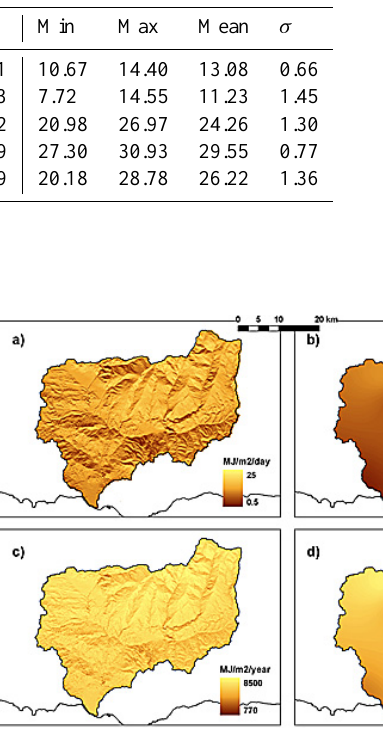
Fig. 3. Daily global radiation (20 November 2004) (a) topograph- ically corrected vs. (b) IDW interpolated, and annual global radia- tion (1 September 2004–31 August 2005) (c) topographically cor- rected vs. (d) IDW